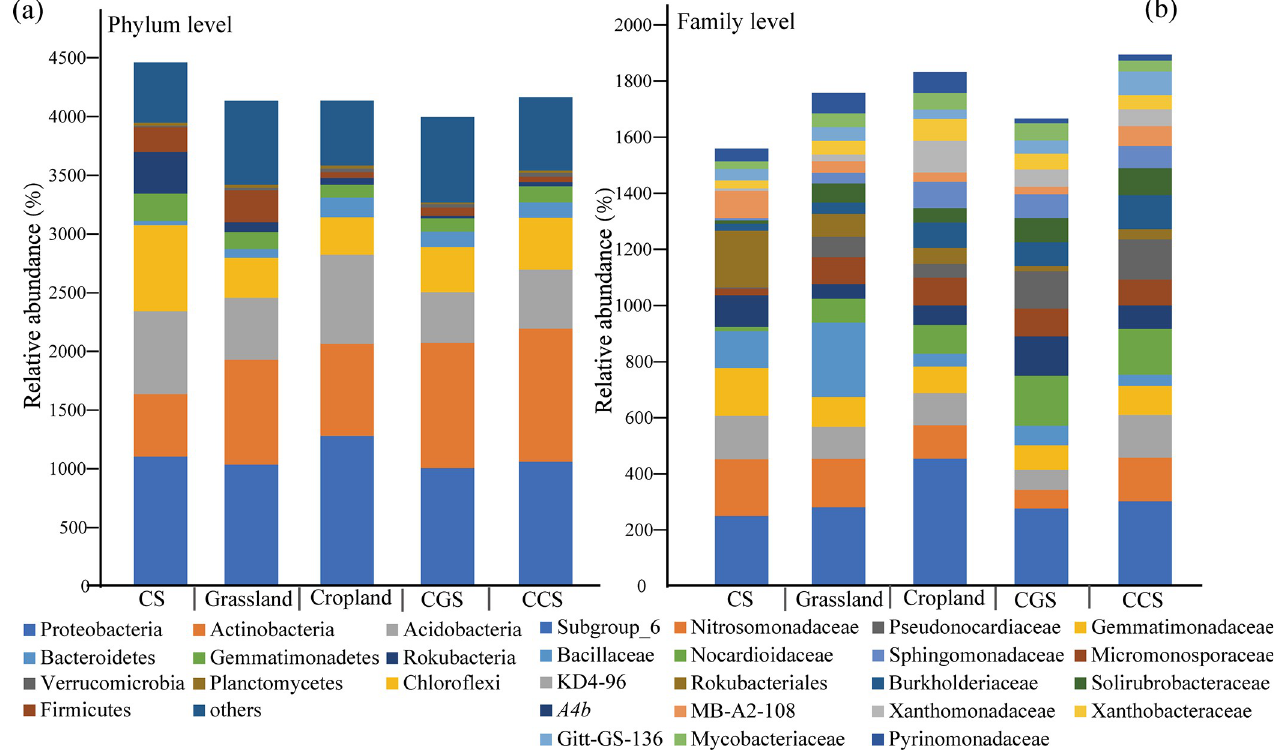
Fig 5. Bacterial relative abundance of cytochrome c biosynthesis function in aerobic respiration based on the MetaCyc (https://metacyc.org/) metabolic pathway prediction.